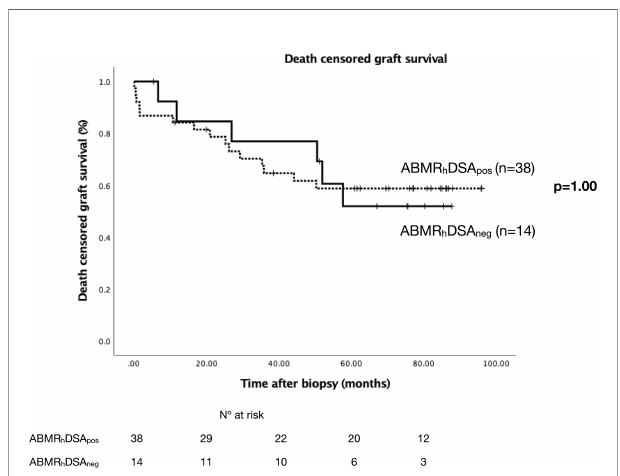
FIGURE 2 | Death censored graft survival in ABMR h patients with and without HLA-DSA. Kaplan – Meier survival curves representing death censored